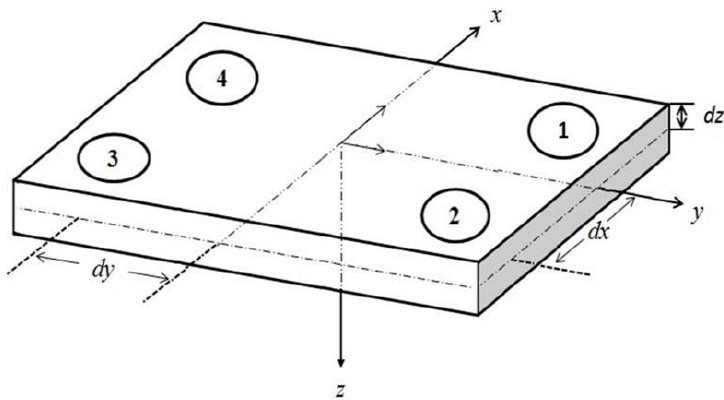
Figure 1. Force plate, its coordinate system, its three geometrical parameters, and locations of the four force sensors.